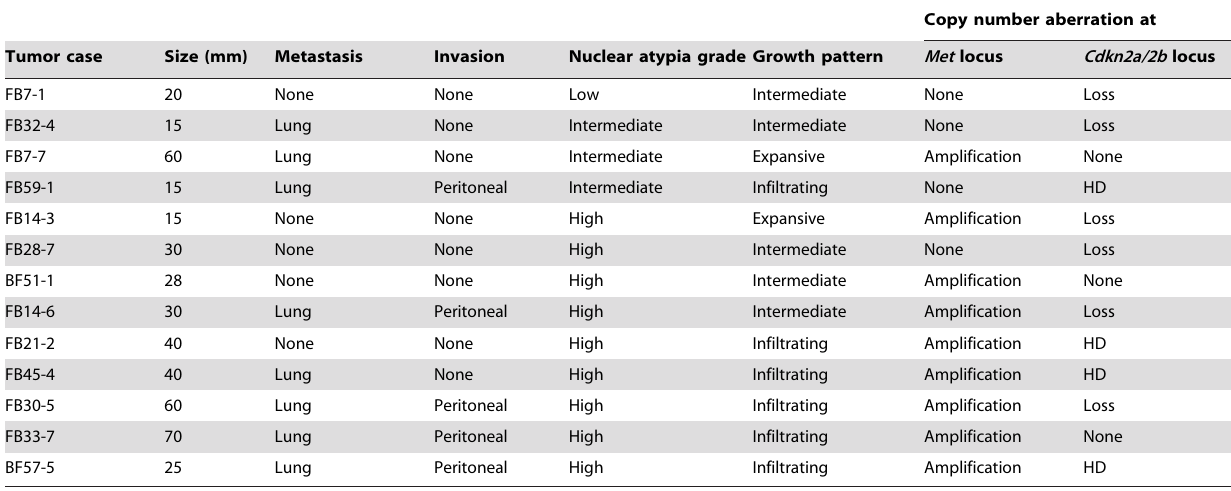
Copy number aberration at